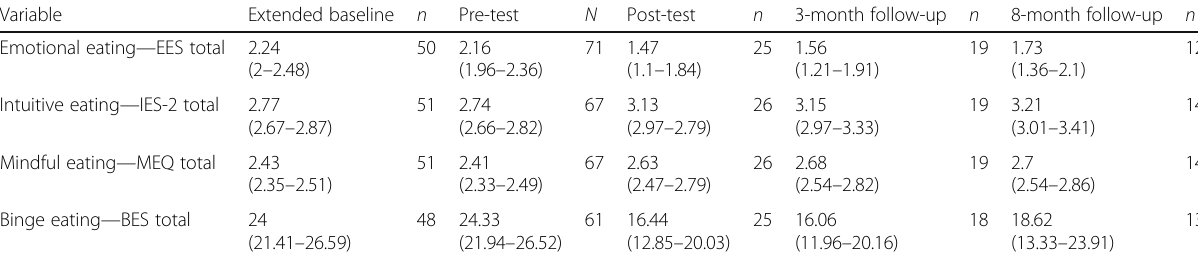
Table 3 Outcomes regarding adaptive and problematic eating behaviors after intervention, 3- and 8-month follow-up Variable Emotional eating — EES total 2.24 (2 –